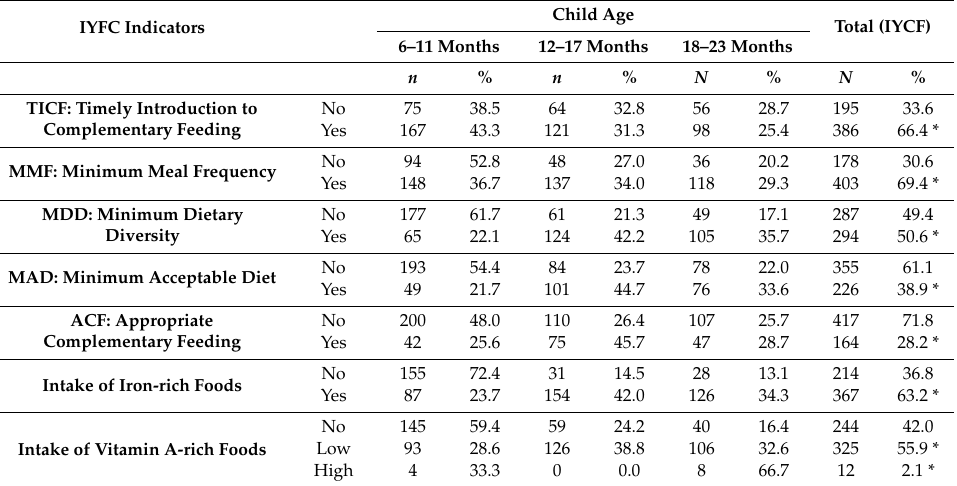
Table 4. Prevalence of IYCF indicators by child age ( n =